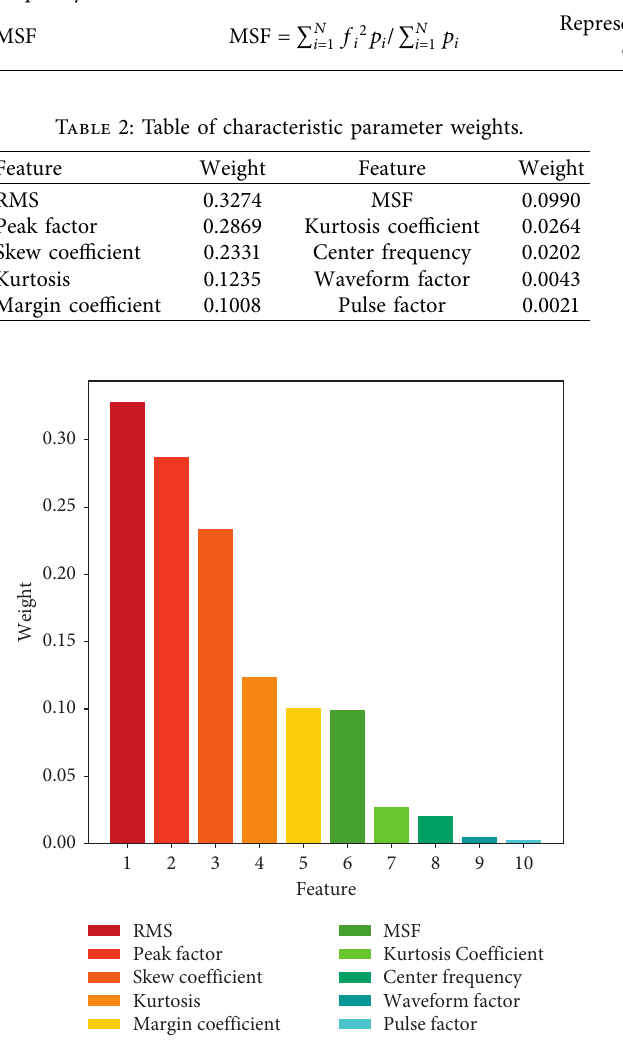
Figure 2: Diagram of characteristic parameter